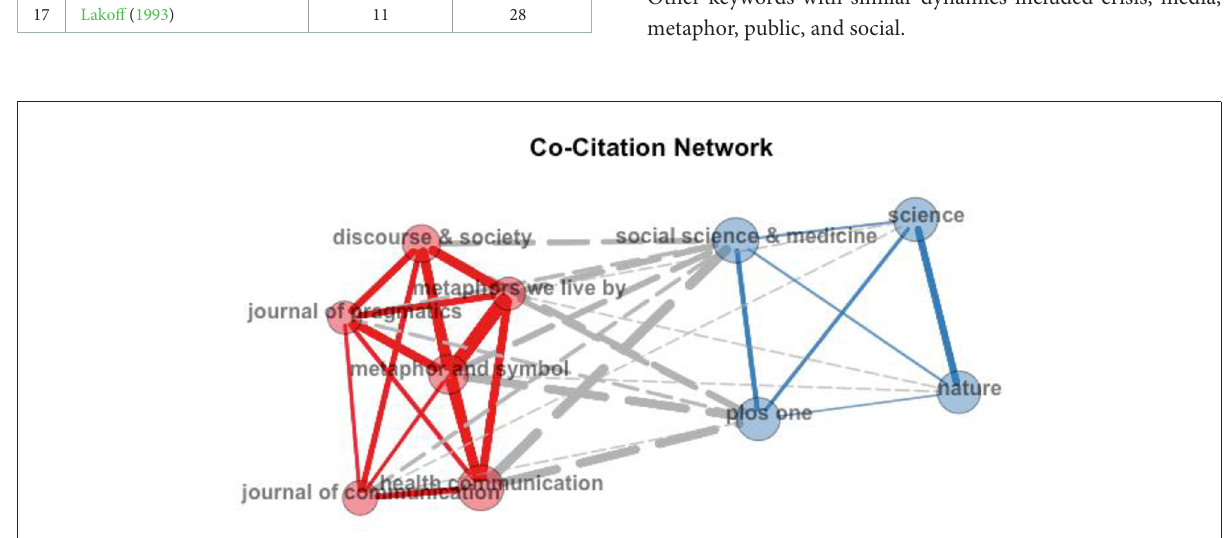
FIGURE5 Visualization of the most-co-cited